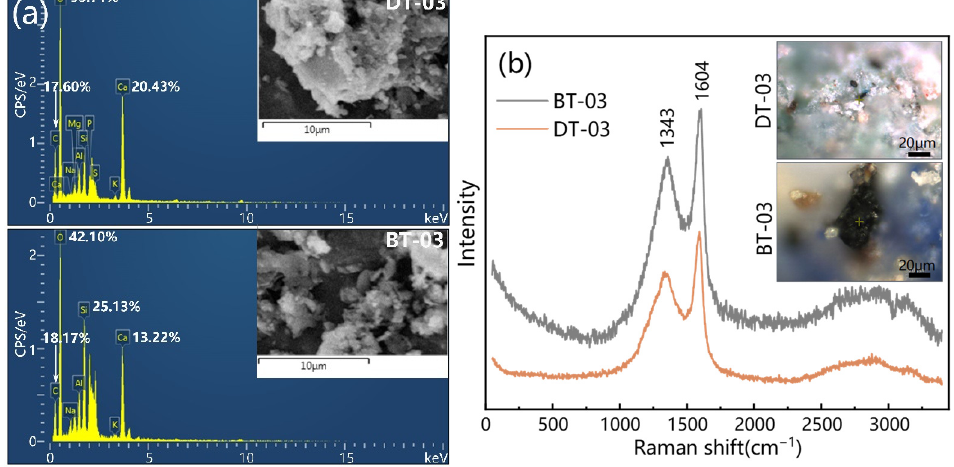
Figure 6. ( a ) Elemental analysis by SEM-EDS and ( b ) Raman spectra for the black samples (DT-03 and BT-03).